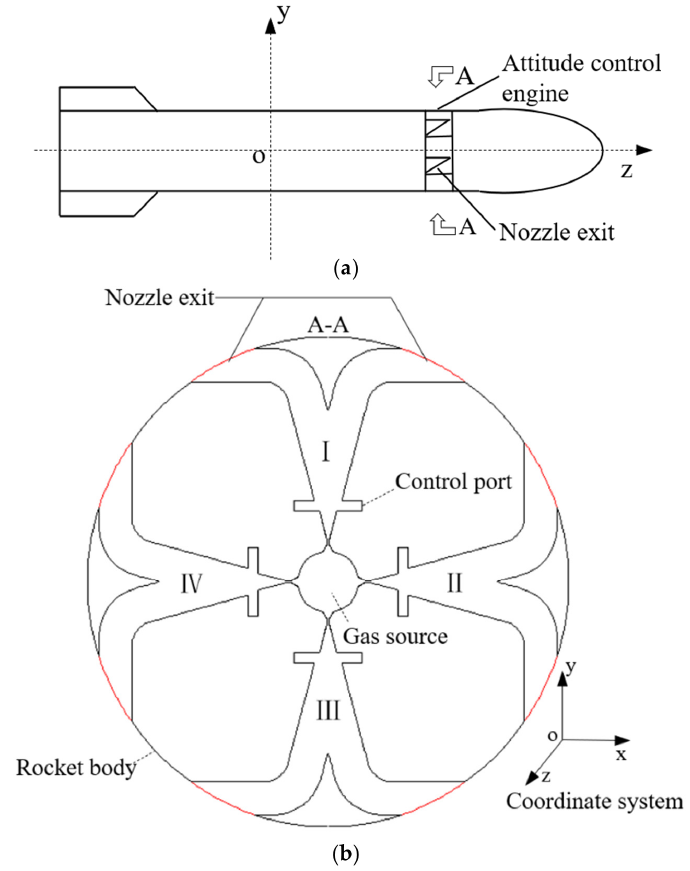
Figure 2. Position ( a ) and structure ( b ) of supersonic fluidic element on rocket.